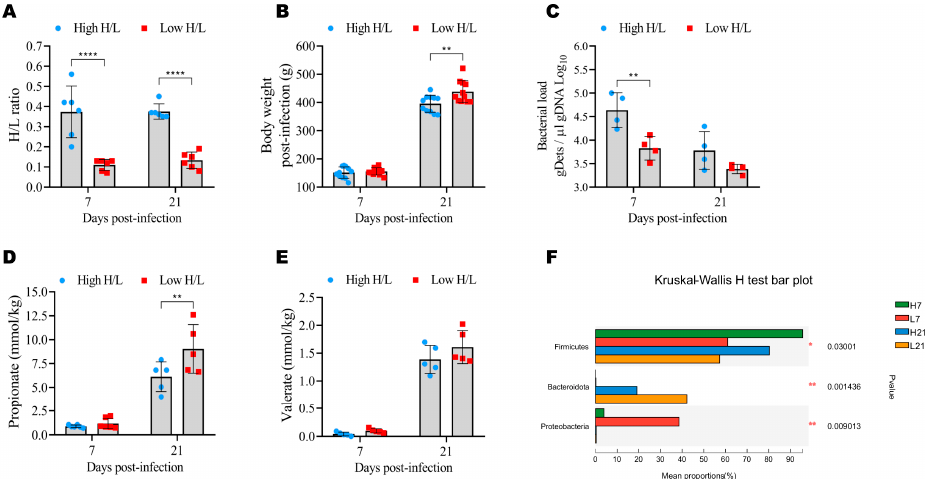
Figure 1. Phenotypic, cecal microbiota and metabolite differences. ( A ) Heterophil/lymphocyte (H/L) ratio of different groups (n = 6). ( B ) Body weight differences between low and high H/L ratio groups at 7 and 21 dpi (n = 11). ( C ) Bacterial load (from the cecum) differences between low and high H/L ratio groups at 7 and 21 dpi (n = 4). ( D ) Propionate differences between low and high H/L ratio groups at 7 and 21 dpi (n = 5). ( E ) Valerate differences between low and high H/L ratio groups at 7 and 21 dpi (n = 5). ( F ) Cecal microbiome relative abundance (at the phylum level) differences between low and high H/L ratio groups at 7 and 21 dpi. Data were analyzed by the Kruskal–Wallis H test, with reported p -value and significance. H7: High H/L SE-infected 7 dpi (n = 8); L7: Low H/L SE-infected 7 dpi (n = 7); H21: high H/L SE-infected 21 dpi (n = 6); L21: Low H/L SE-infected 21 dpi (n = 7). * p < 0.05, ** p < 0.01, **** p < 0.0001. Data analysis was performed using 2-way ANOVA with Sidak’s multiple comparisons, with alpha = 0.05.